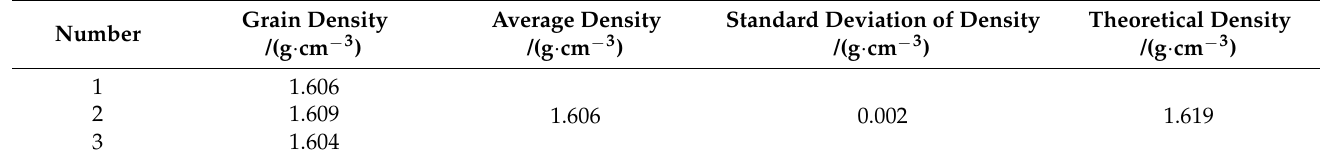
1µm Figure 9. SEM images of the cross-section of the 3D-printed grain: ( a , b ) the micro-topog- raphy of the cross-section of the grain; ( c , d ) a further detail of the micro-topography of the cross-section of the grain; ( e ) SEM images of a further detail of the cross-section of grain; ( e1 – e5 ) EDS images of Al, Cl, C, N and O elements in ( e ). It can be seen from Figure 9a,b that the 3D-printed grains have good cross-section integrity, compact structure, and no obvious cracks, holes and other defects. In addition, it can be seen from Figure 9c,d that no obvious cracks, holes and other defects are still found in the grain cross-section under a larger magnification, and the cross-section is rel- atively complete as a whole. It can be seen from Figure 9 (e1–e5) that Al, Cl, C, N and O elements are uniformly distributed inside the 3D-printed grain, indicating that the distri- bution of oxidant (AP), reductant (Al) and resin systems in the system is relatively uni- form. The SEM/EDS of the cross-section of the grain shows that the light-curing 3D print- ing technology has achieved a compact internal structure of the energetic grain and re- duced the formation of defects; at the same time, all elements in the grain were uniformly distributed.